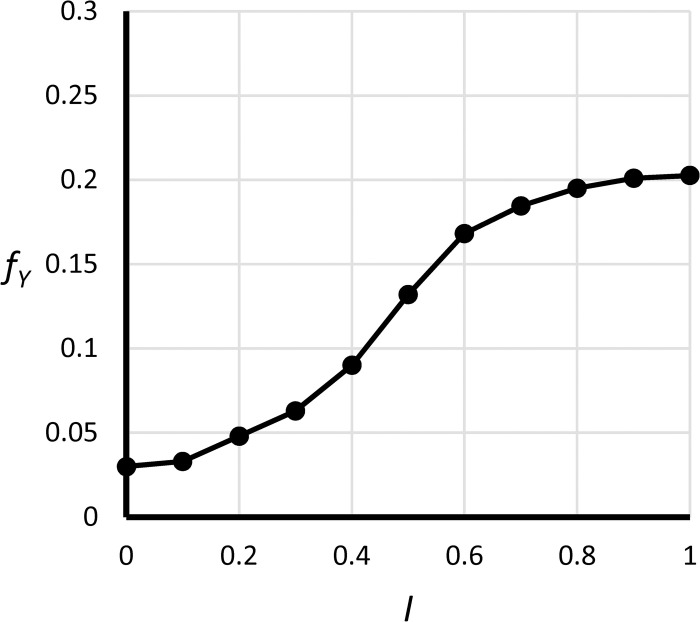
Graphical function fy(I).